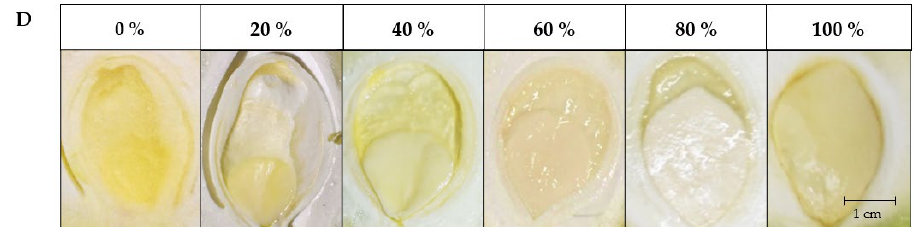
Figure 1. Morphology of the fruit and seed of chayote Sechium edule var. virens levis at horticultural maturity (18 ± 2 days after anthesis). ( A ) Fruit description; ( B ) seed components; ( C ) fruit with germinated seed and embryo; ( D ) scale of cotyledon development.